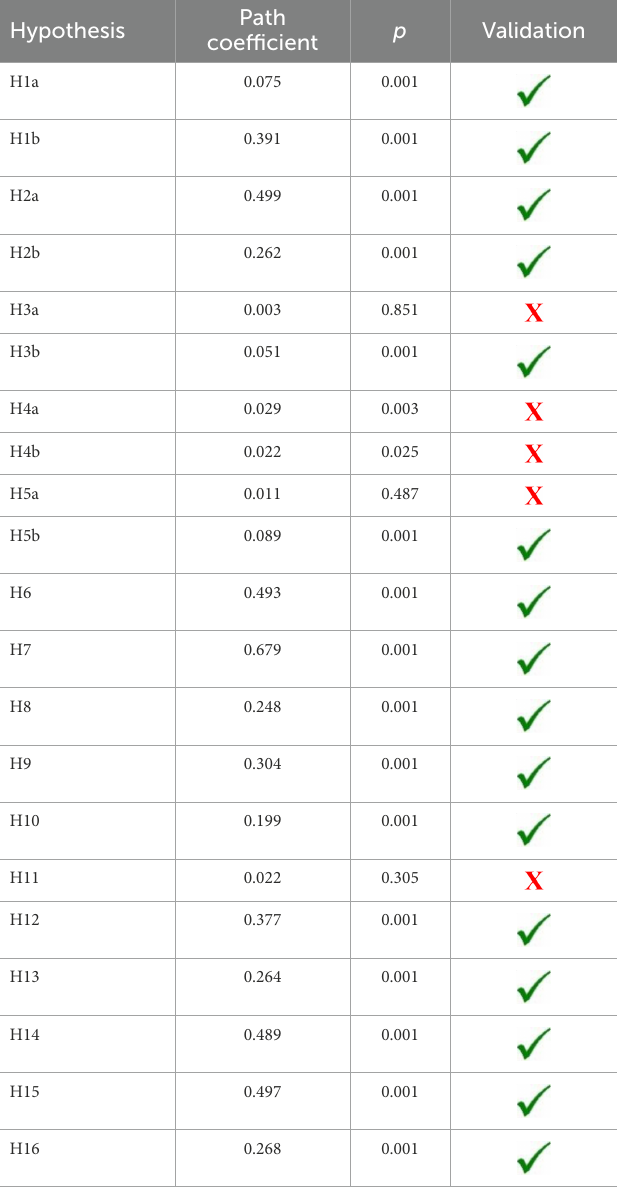
TABLE 5 Hypothesis validation. Hypothesis